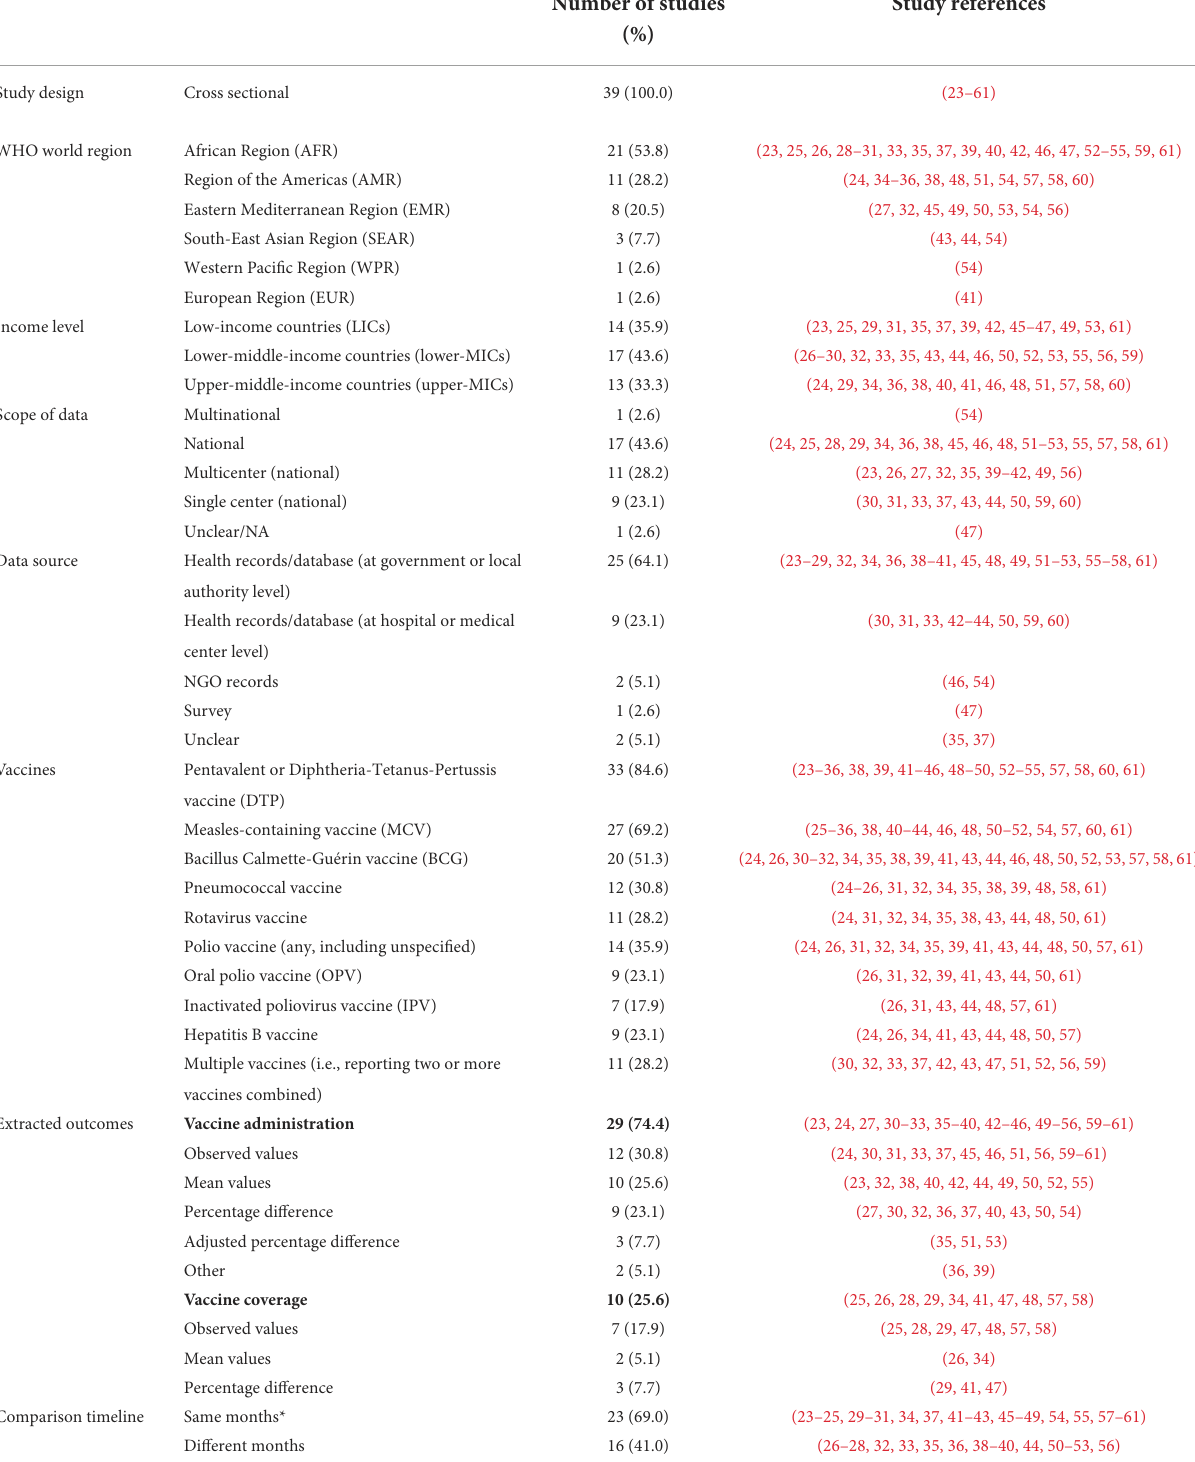
TABLE 1 Summary of study characteristics for studies reporting changes to vaccination levels ( n =